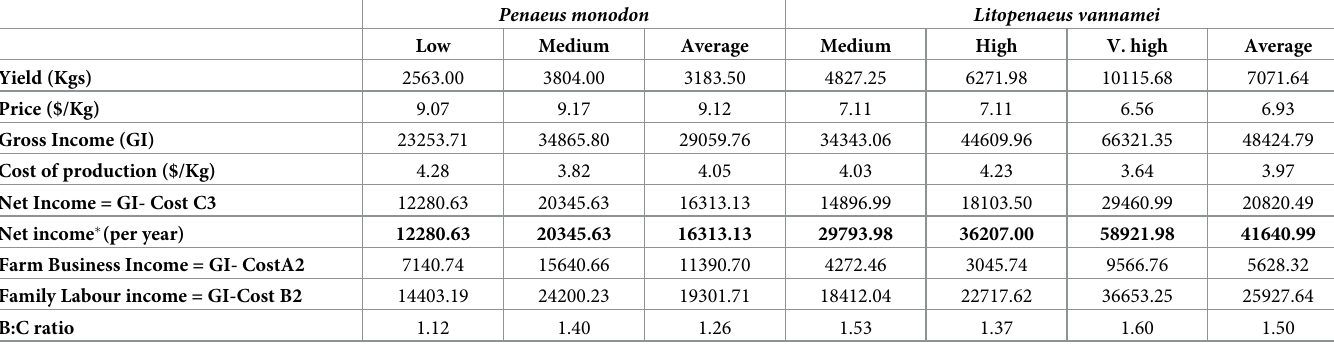
Table 6. Returns from cultivation of shrimps on sample farms per hectare